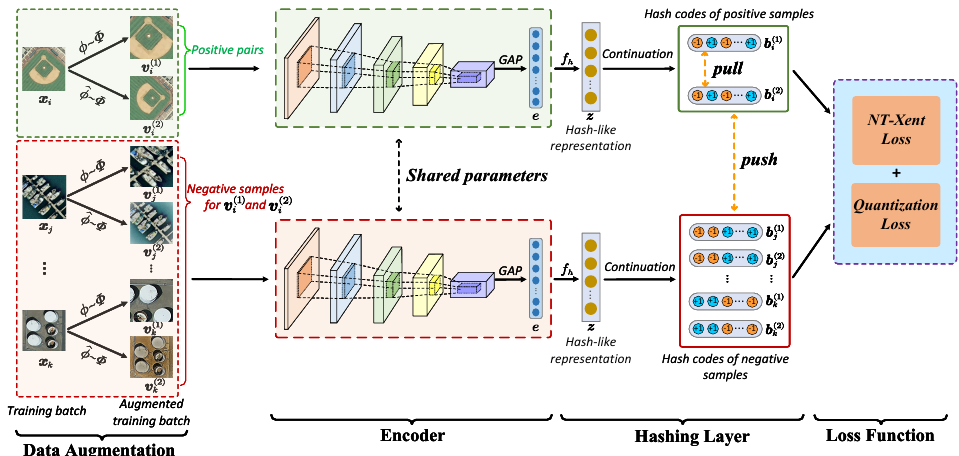
Figure 1. The framework of deep contrastive self-supervised hashing (DCSH). It consists of four components: data augmentation, encoder, hashing layer and objective loss function. Firstly,